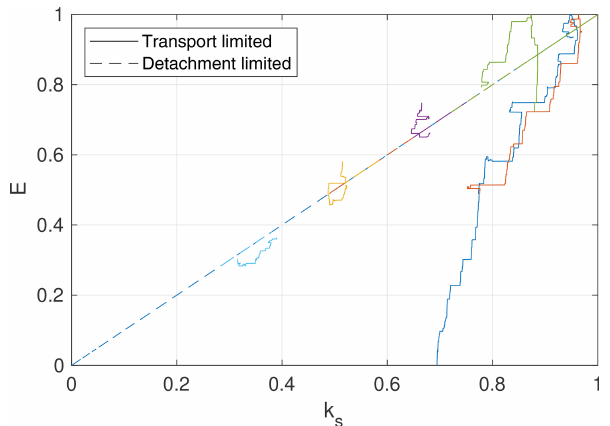
Figure 5. Erosion rate E ( = U ) vs. steepness index k s for the rivers marked in Fig. 2.